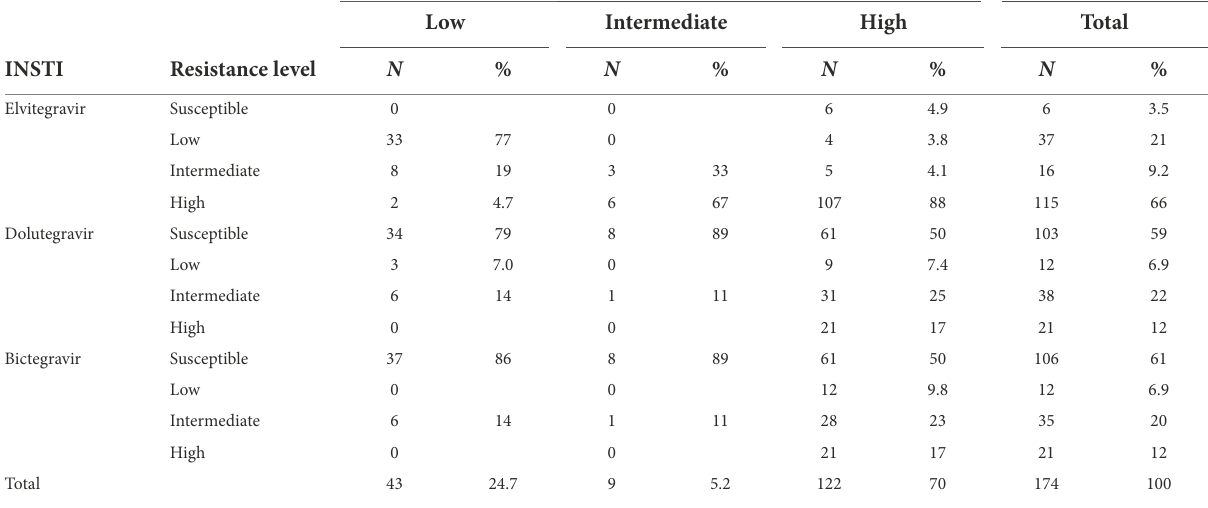
TABLE 4 Resistance levels to raltegravir compared to the other